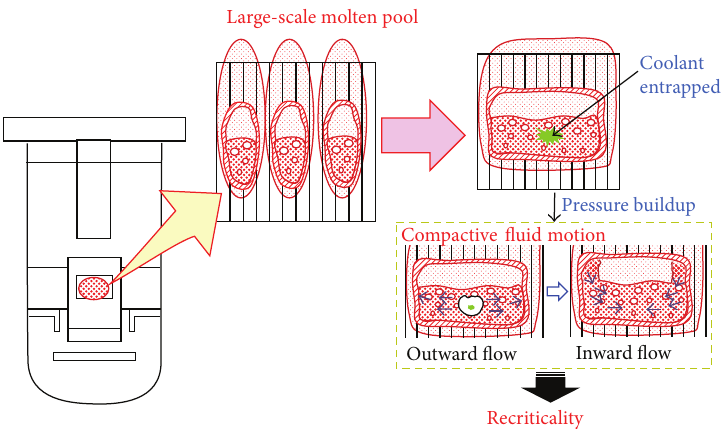
Figure 1: Large-scale molten pool formed during transition phase.